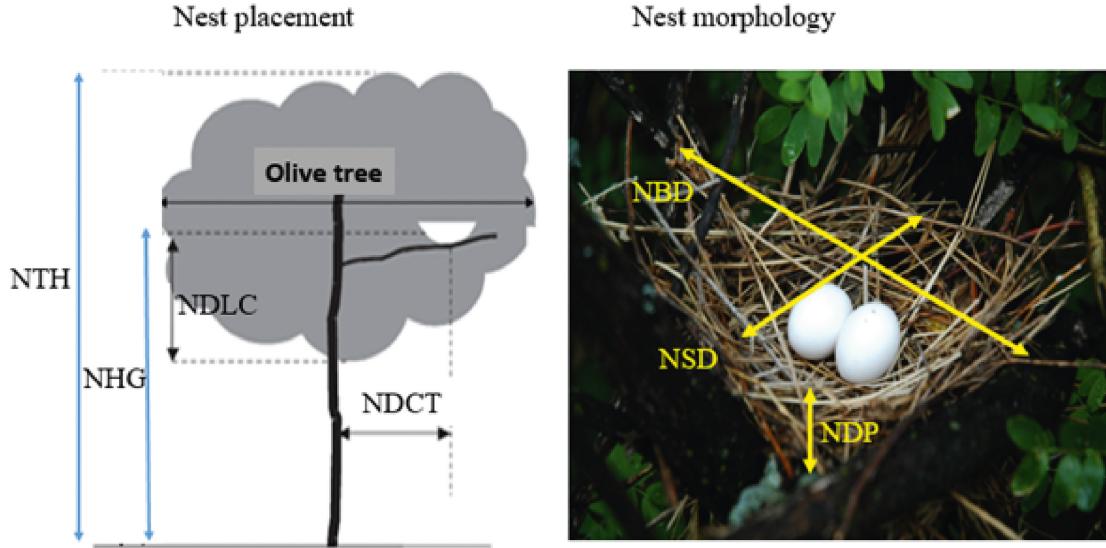
Figure 3: Measured parameters for nest placement and